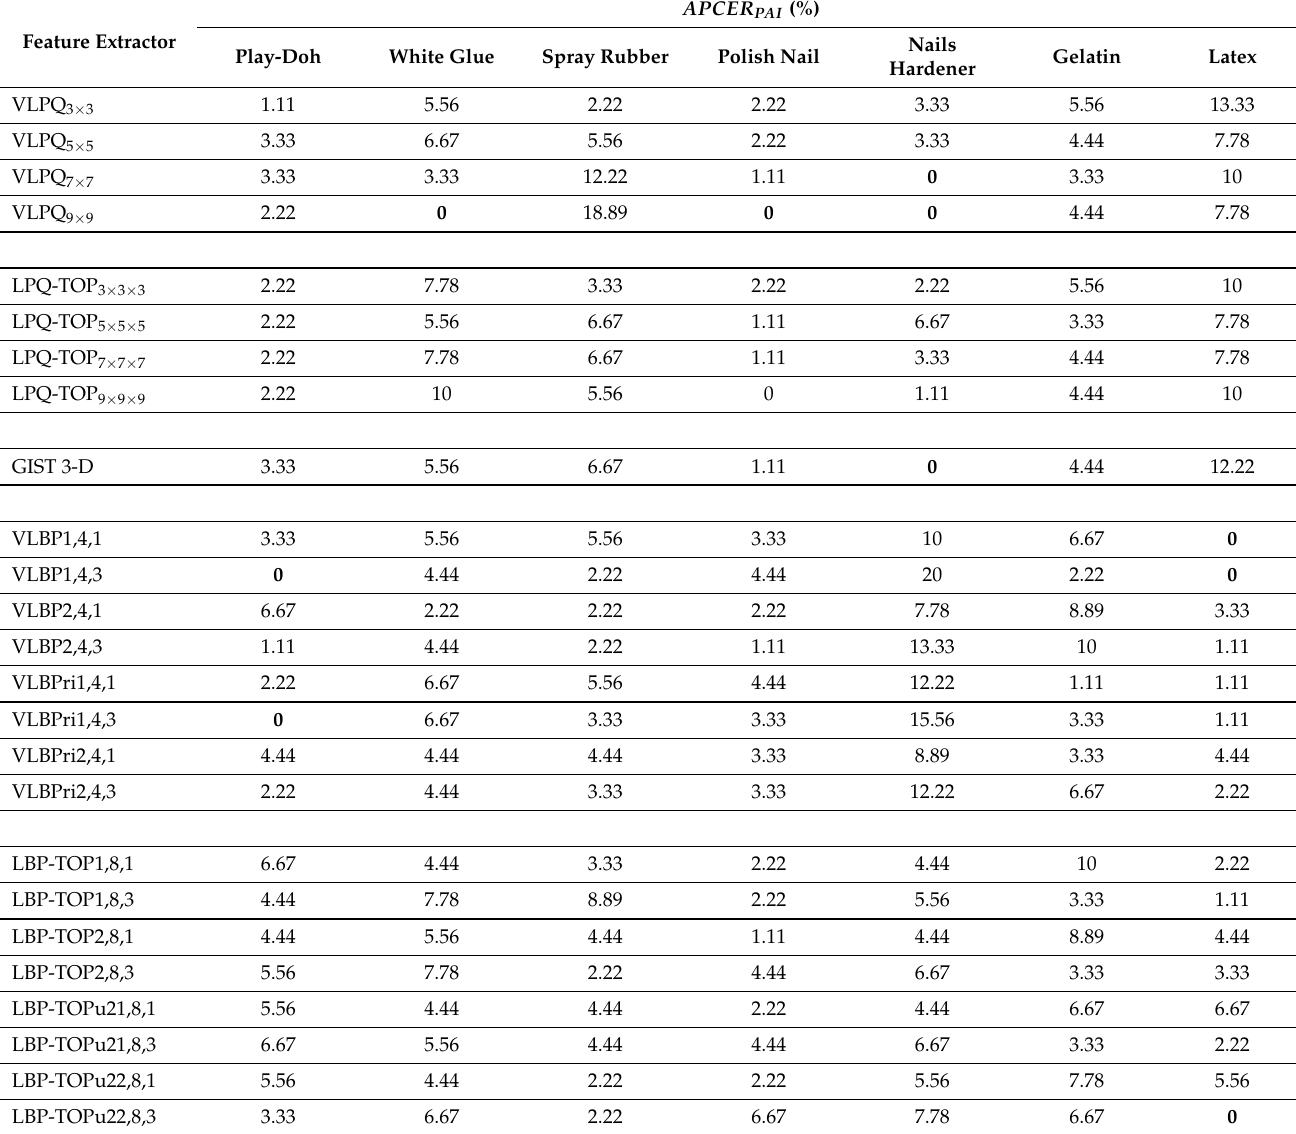
Table 8. PAD subsystem performance for the optical